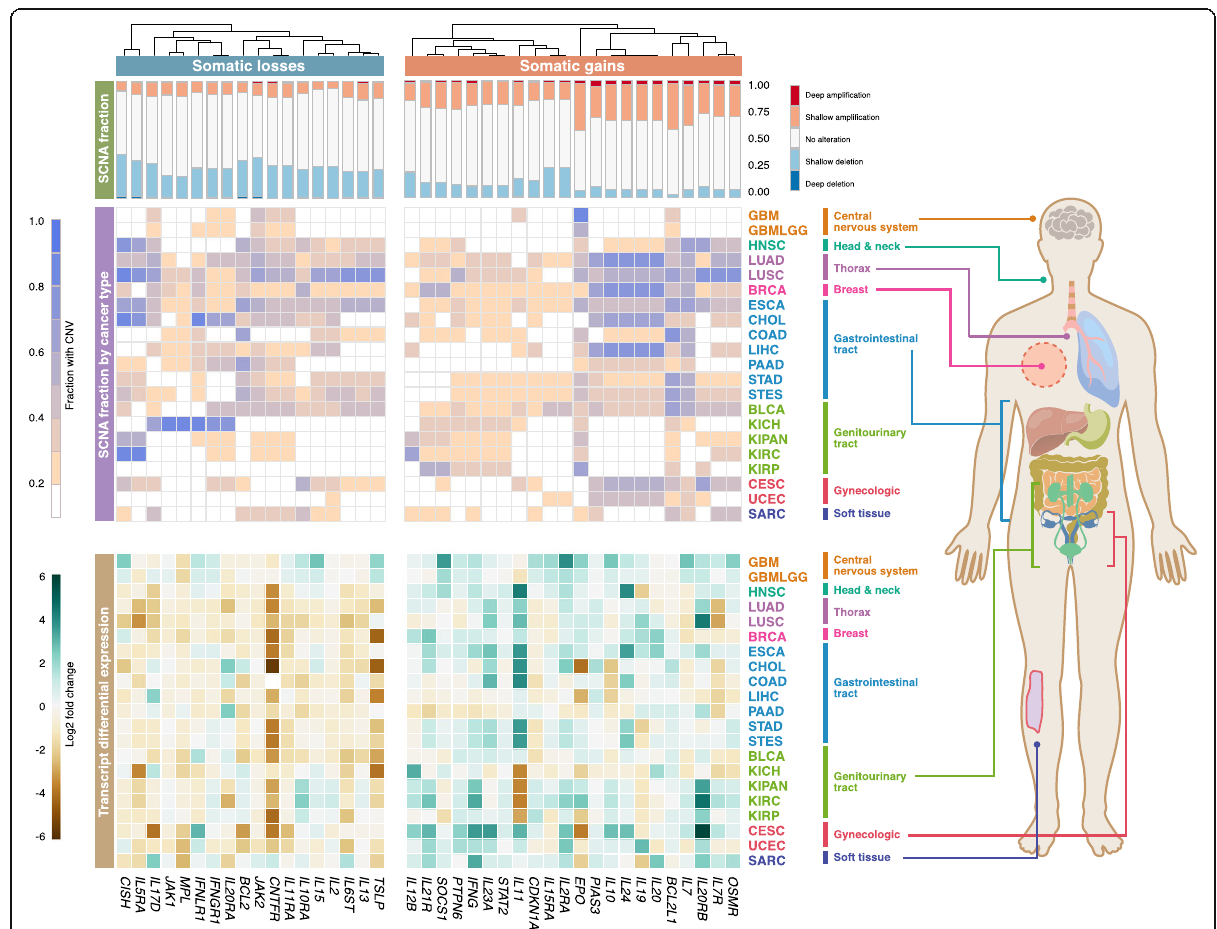
Fig. 1 Pan-cancer genomic and transcriptomic alterations of JAK-STAT pathway genes. Stacked bar charts depict the fraction of altered samples for each of the 40 putative driver genes. Heatmap in the center illustrates the fraction of somatic gains and losses per gene within each cancer type. Heatmap below illustrates differential expression profiles (tumor vs. non-tumor) for each gene. Hierarchical clustering is performed on columns (genes) using Euclidean distance metric. Cancer abbreviations are listed in the Methods